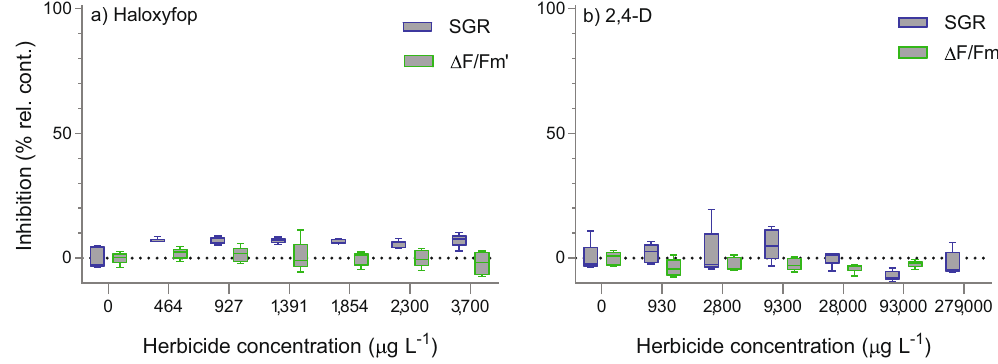
Figure 3. Response of Rhodomonas salina to ( a ) haloxyfop and (b) 2,4-D. Boxplots showing percent inhibition relative to control treatments in 3-day specific growth rate (SGR d − 1 ) and 24 h effective quantum yield ( Δ F/F m ′ ) (n = 5 for each treatment).